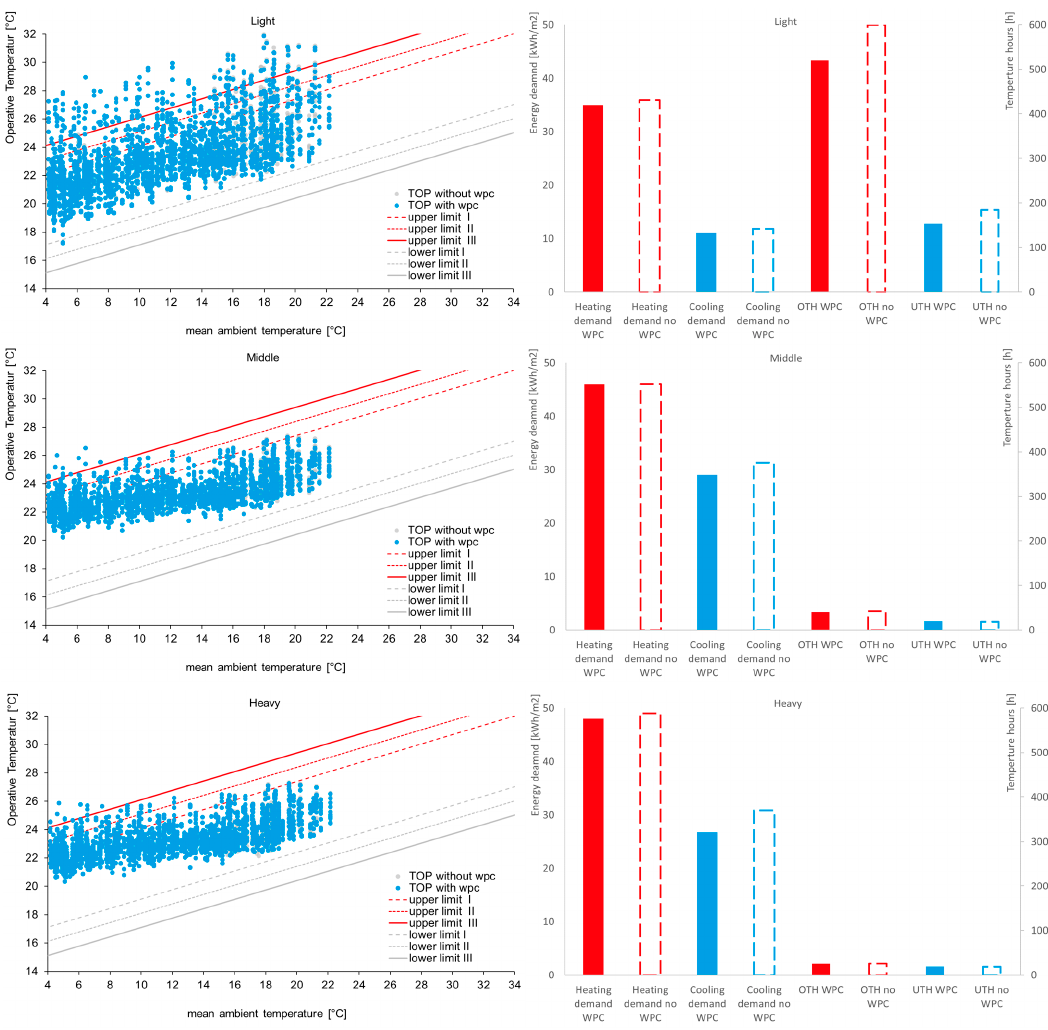
Figure 8. Simulation Results: Left column: Comfort hours with (blue) and without WPC (grey) for a lightweight ( top ), middle ( middle ) and heavy ( bottom ) construction; right column: Heating (red) and cooling (blue) demand and over (red) and under temperature hours (blue) with (solid color) and without (dashed) WPC (own representations).